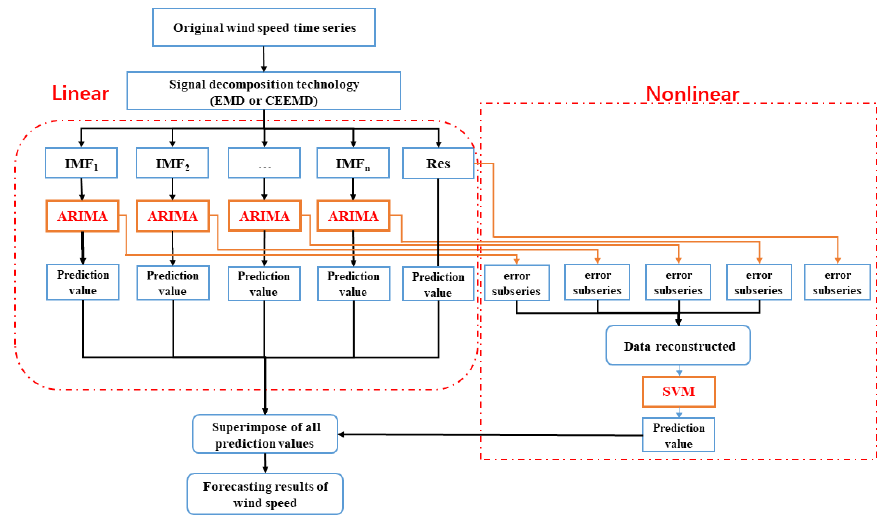
Figure 1. Framework of the hybrid forecasting model.